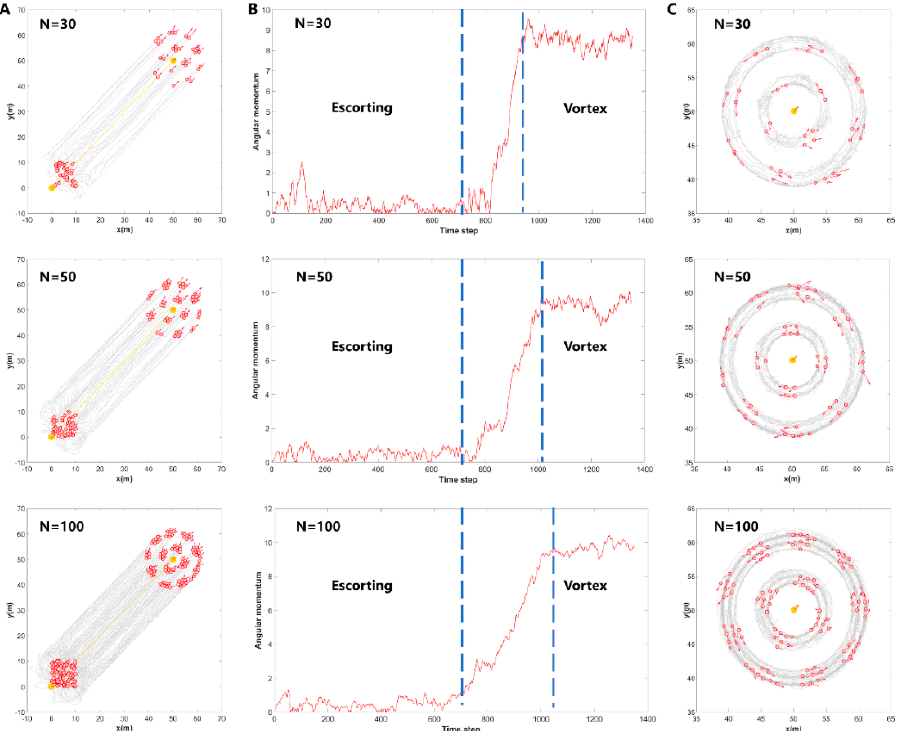
Figure 5. Escort under the environment without attackers. ( A ) Escort formations with different size of escort swarm. ( B ) Angular momentum of the escort swarm with different size. ( C ) Vortex trajectories with different size of escort swarm.